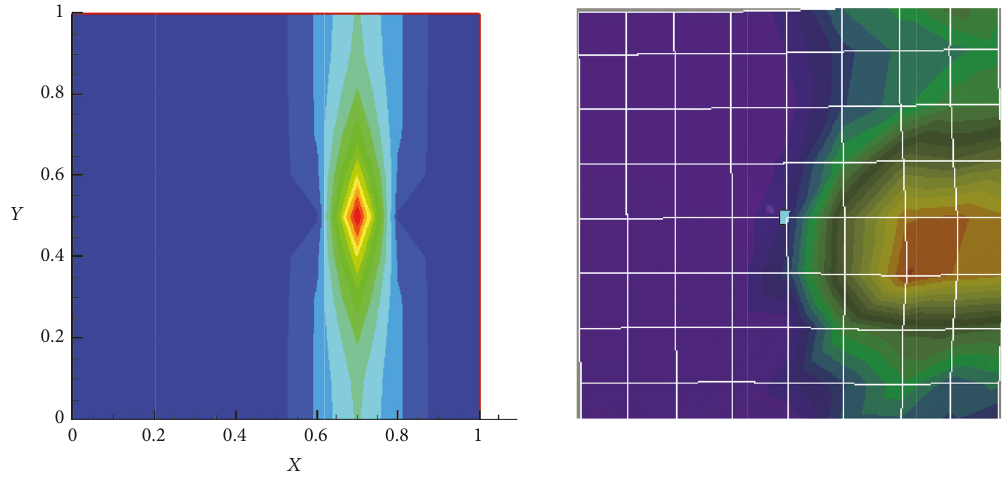
Figure 10: Comparison of test results and prediction results.